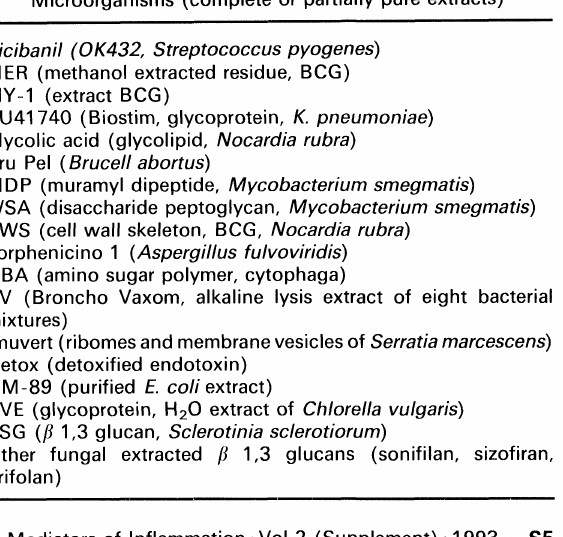
Table 2. Biological response modifiers of biological origin Microorganisms (complete or partially pure